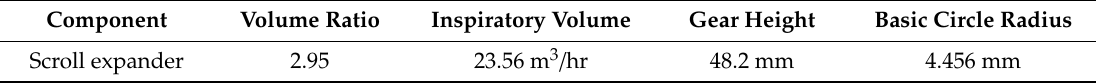
Table 2. Parameters of the scroll expander.